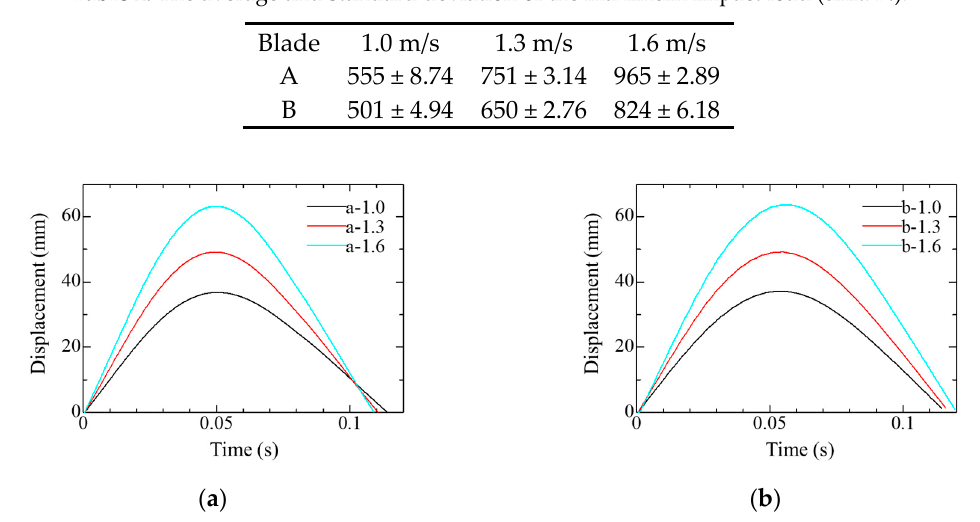
Figure 4. Experimental results of the impact load response about the x axis: ( a ) blade A; ( b ) blade B. Time 0 represents the beginning of the impact, which was identified using high-speed images. The black, red and blue lines represent the results at impact speeds of 1.0, 1.3 and 1.6 m/s, respectively. Table 2. The average and standard deviation of the maximum impact load (unit: N).